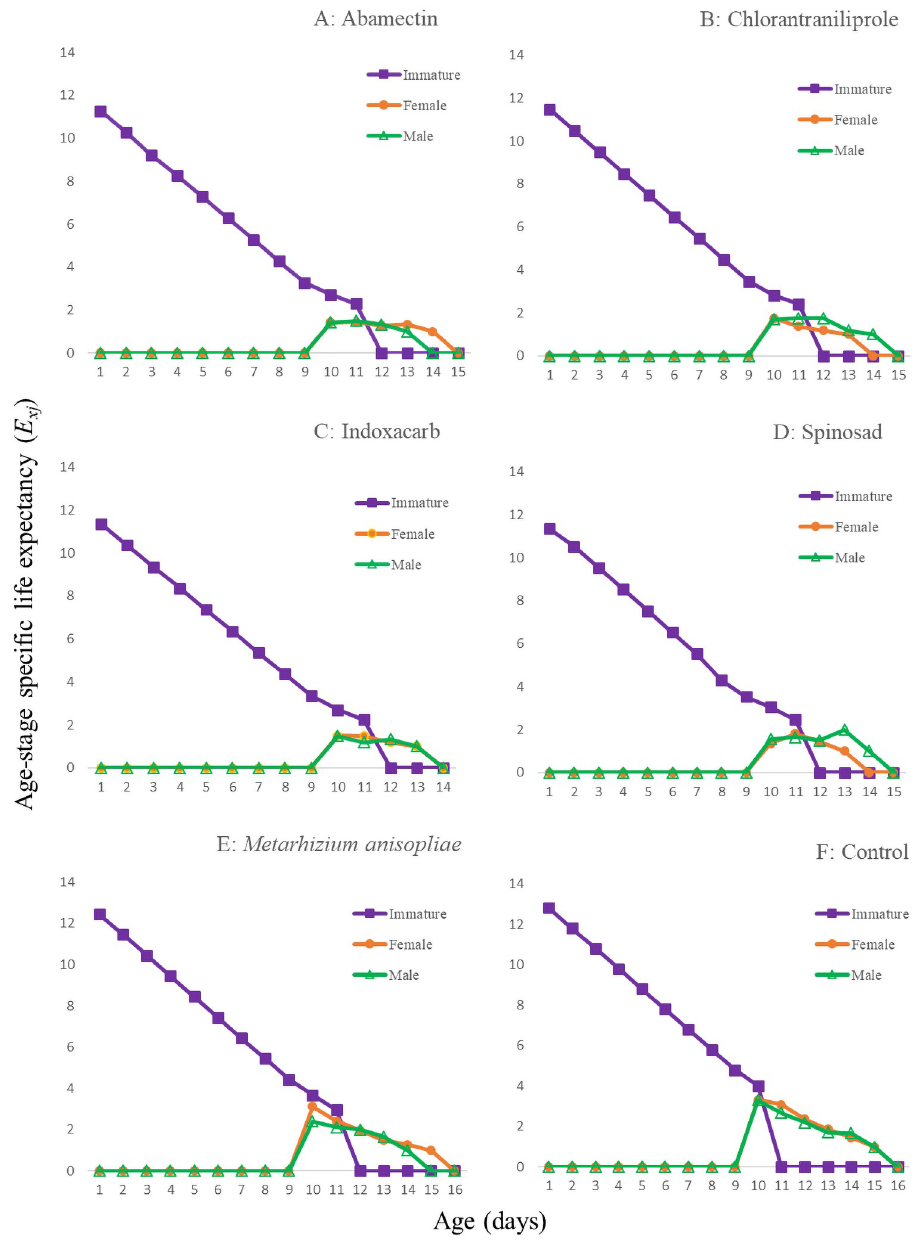
Fig 3. Age-stage specific life expectancy ( E spraying, A: Abamectin, B: Chlorantraniliprole, C: Indoxacarb, D: Spinosad, E: M . anisopliae , F: control.